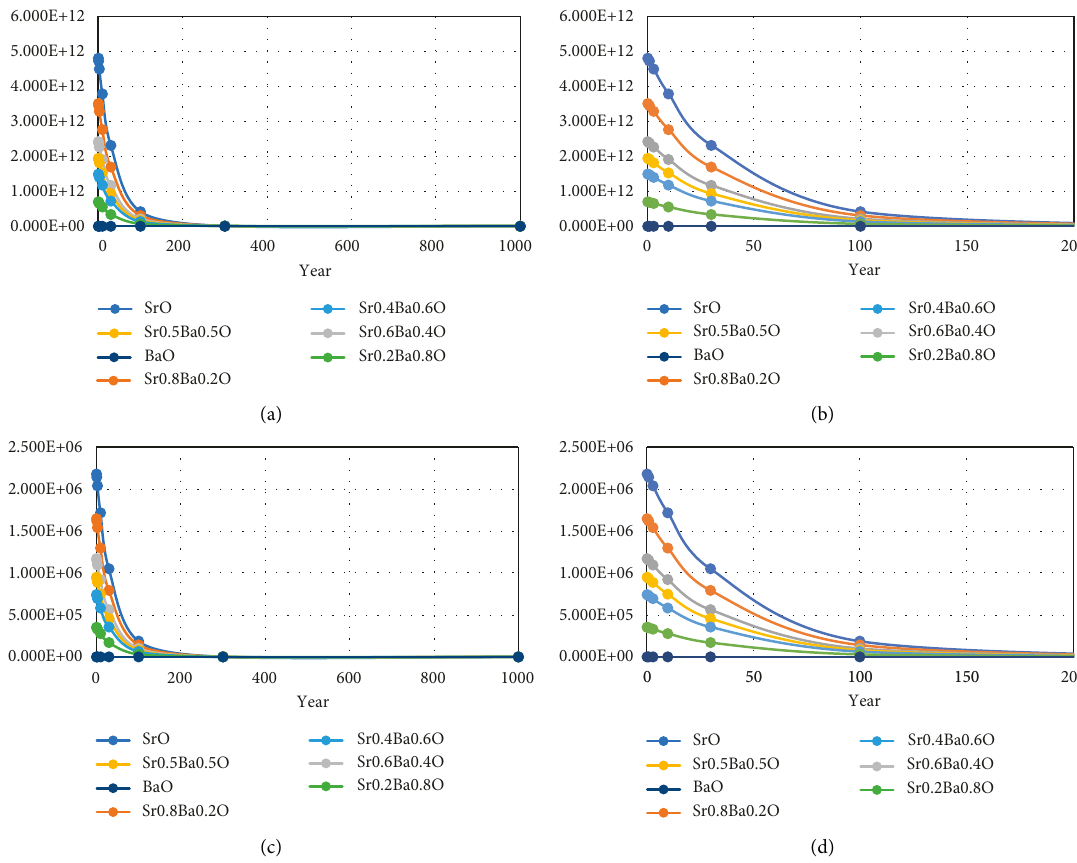
Figure 3: Radiological characteristics of Sr waste according to Sr/Ba ratio ((b) and (d) correspond to magnified graphs of (a) and (c), respectively).